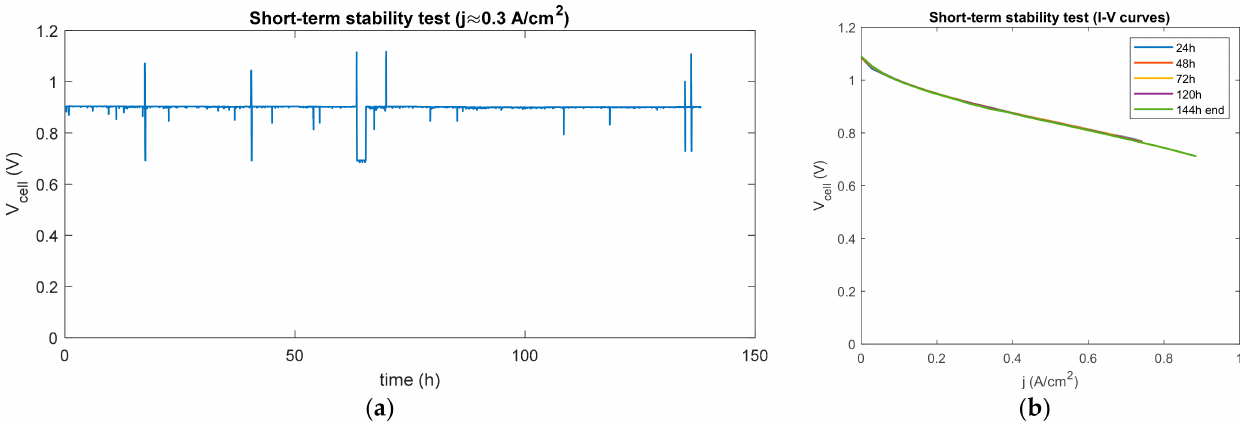
Figure 8. Experimental short-term stability test results: ( a ) cell voltage acquisition; ( b ) daily IV curves performed during the short-term